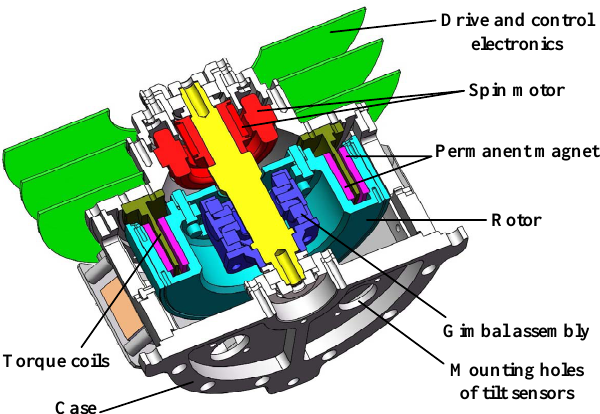
Figure 1. Cut-away view of the GyroWheel